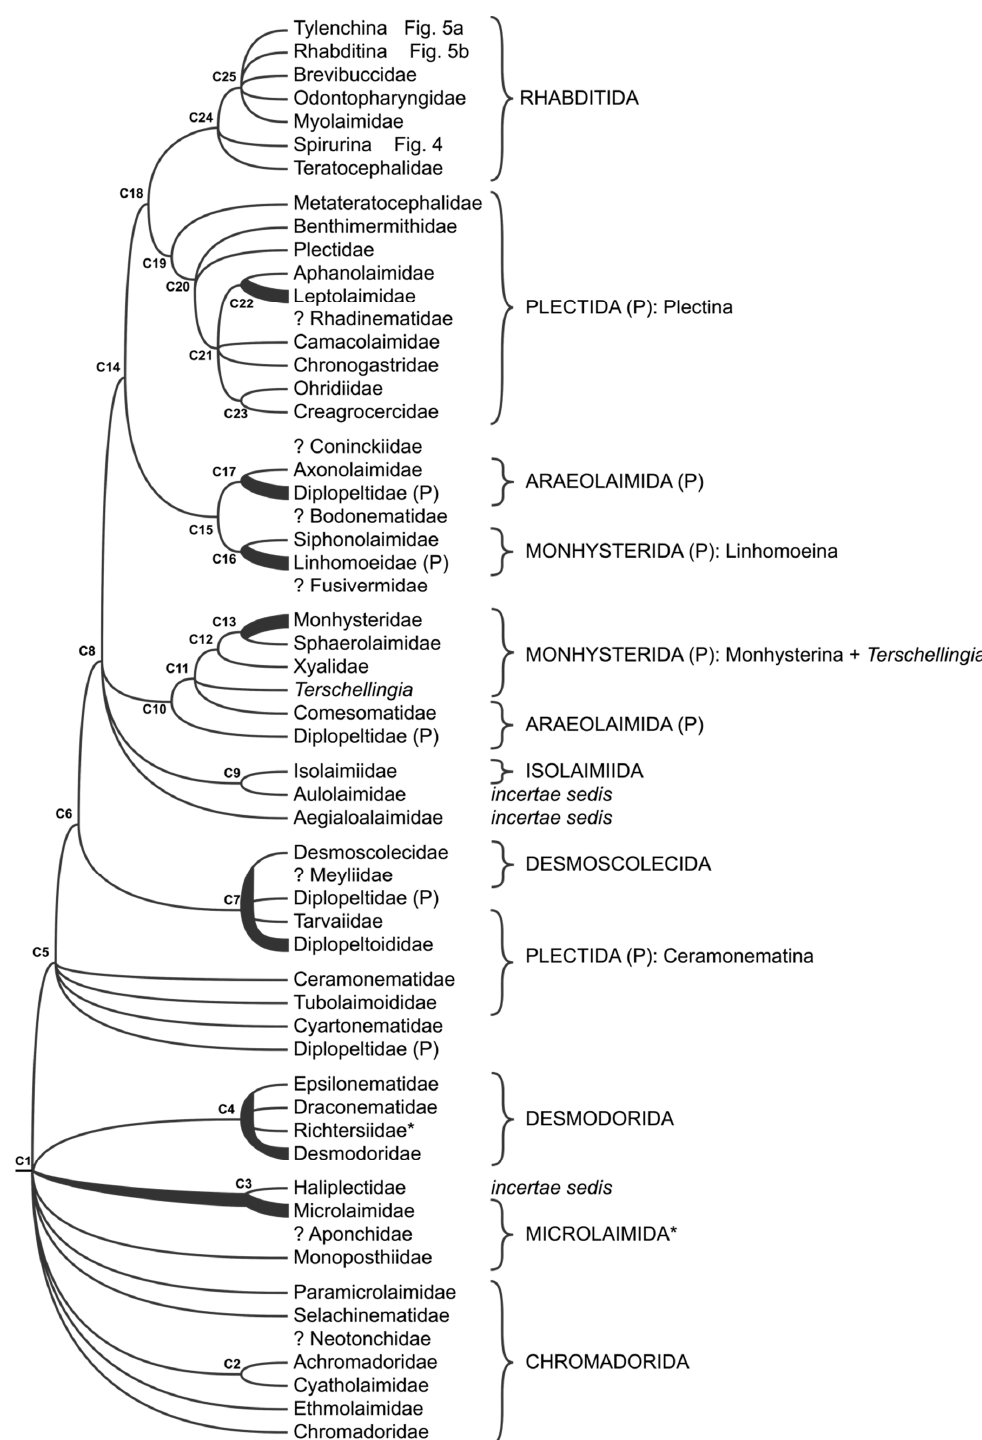
Figure 3. Overview of phylogenetic relationships within Chromadoria. Taxa marked with “*”were not included in the classification of De Ley and Blaxter [2,3]; (P) marks polyphyletic taxa; “?” indicates taxa not included in molecular phy- logenies.